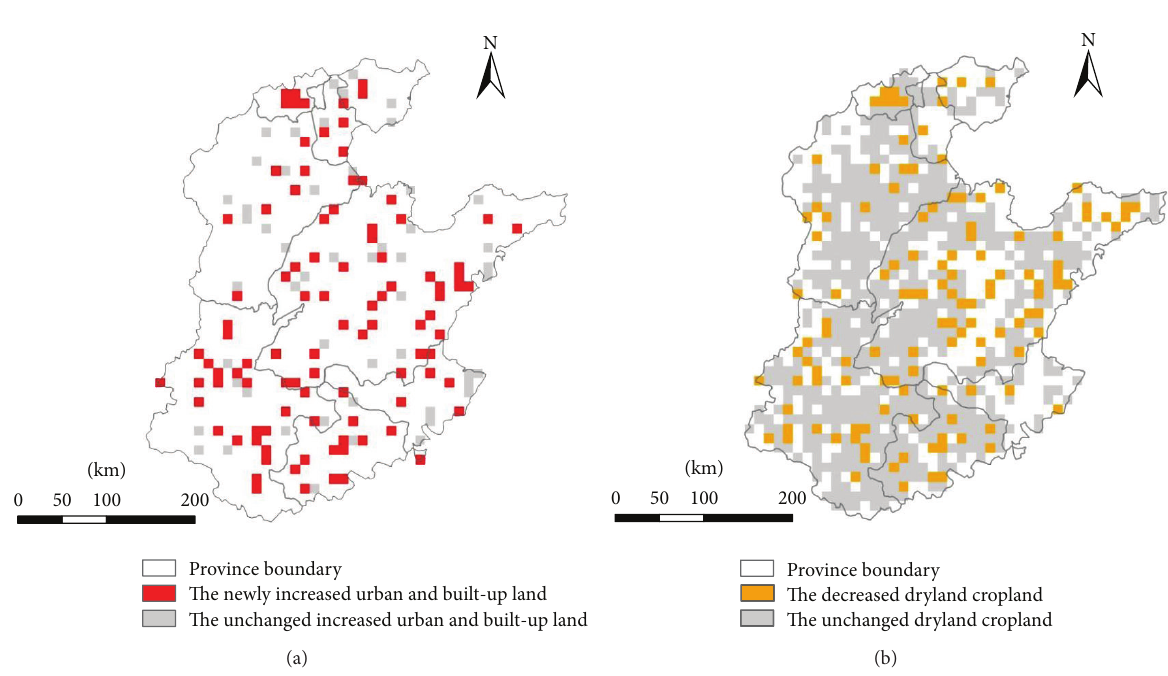
Figure 3: Map of the unchanged and newly increased urban and built-up land (a) and map of the unchanged and decreased dryland cropland